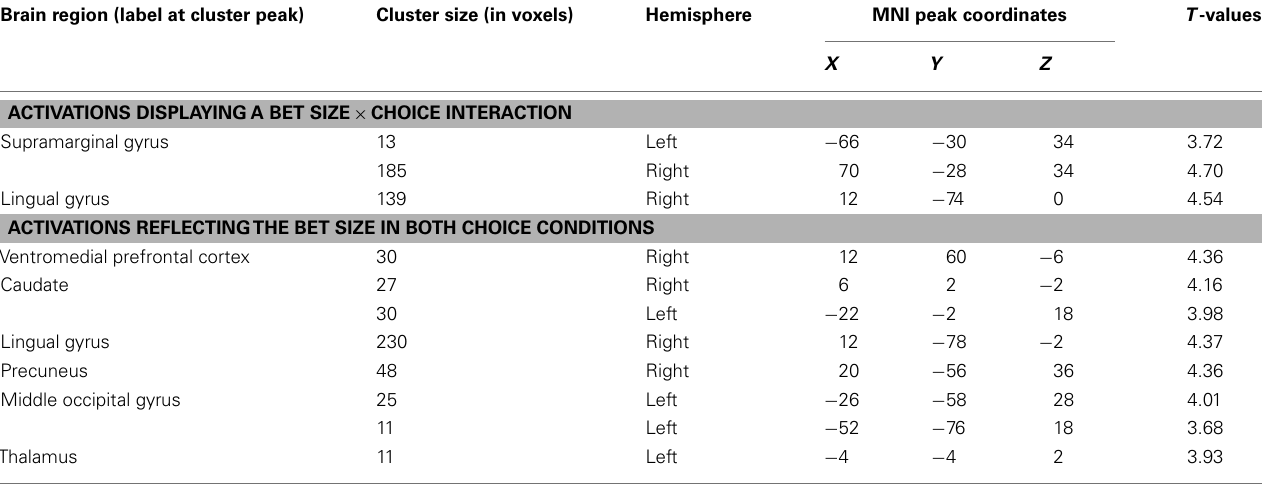
TableA3 | Neural correlates of bet size during selection (whole-brain analysis, P < 0.001, k = 10). Brain region (label at cluster